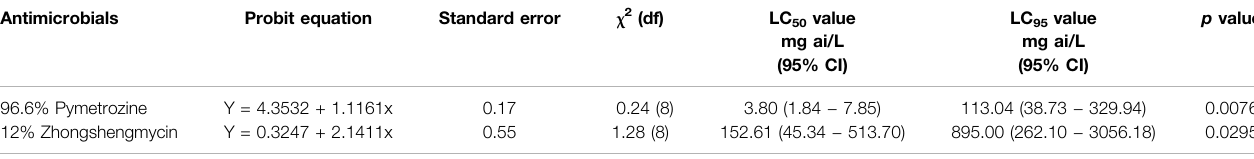
TABLE 2 | Median lethal concentrations of pymetrozine and zhongshengmycin on third instar nymphs of Nilaparvata lugens . Antimicrobials